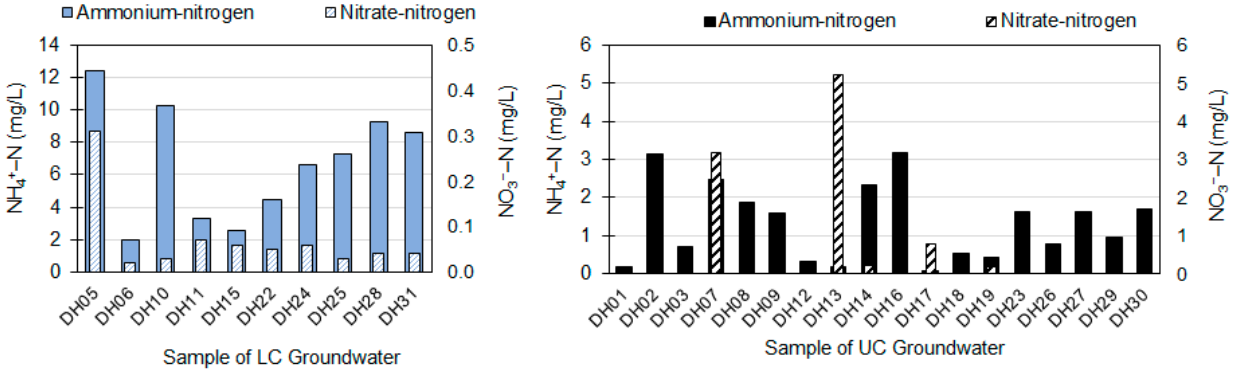
Figure 5. Concentrations of NO 3 − –N and NH 4+ –N (mg/L) in the groundwater samples.